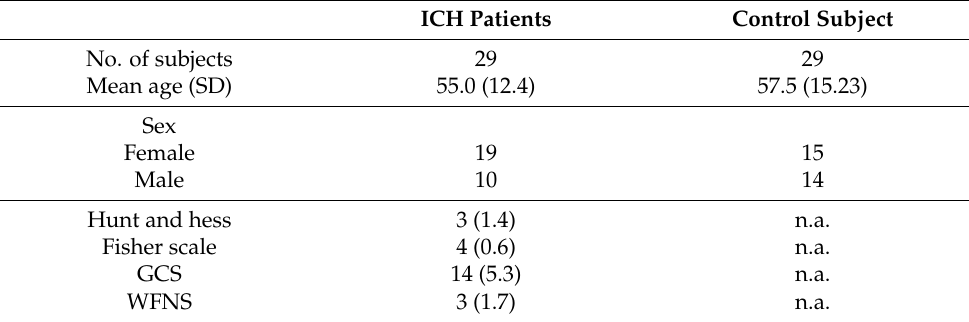
Table 1. Baseline demographics and patient